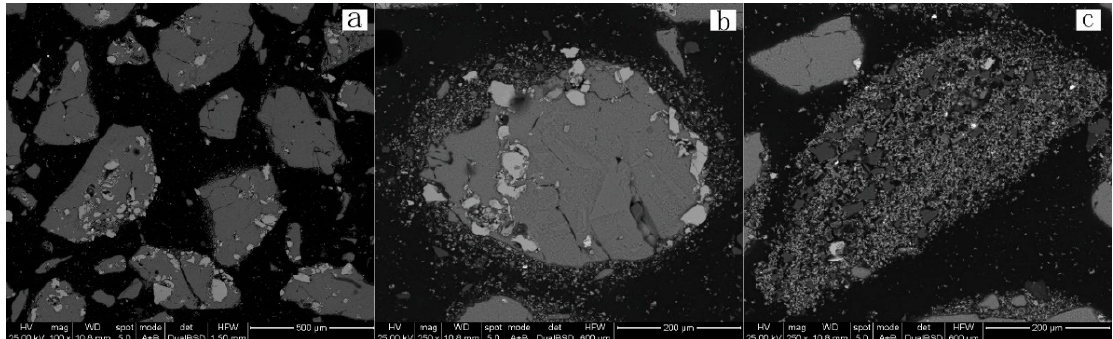
Figure 19. BSE images of 160 °C leach residue. Scale: ( a ) 500 μ m; ( b ) 200 μ m; ( c ) 200 μ m.